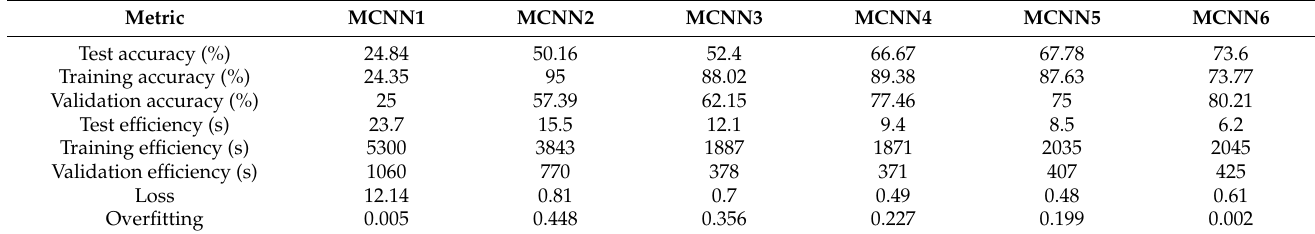
Table 2. Test results based on the